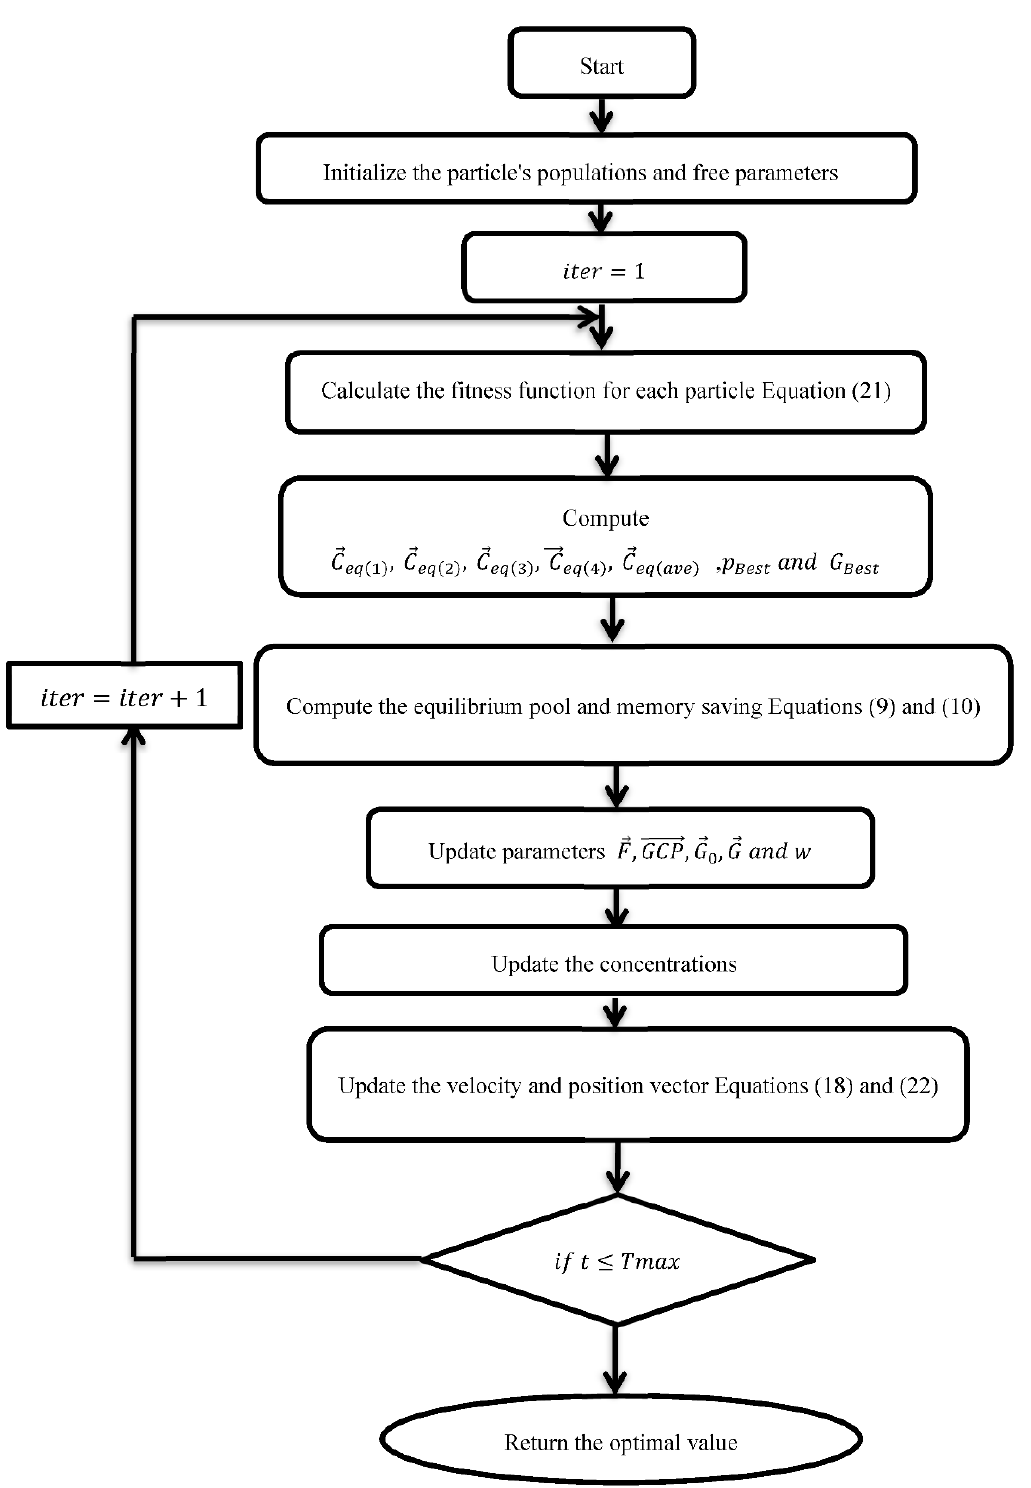
Figure 6. The flow chart of BHPSOEO algorithm.